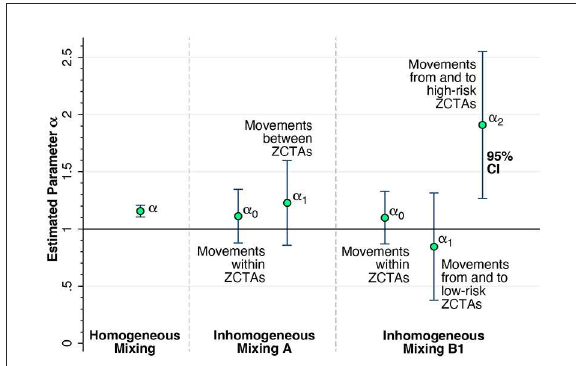
FIGURE9 Estimates of the reproductive number α from a series of geospatial analyses. (Left) Estimate of a uniform parameter α = 1.157 with 95% confidence interval [1.106, 1.208] for the entire regulated region, based upon the assumption of homogeneous mixing. The estimate of α is significantly different from 1.0 (2-sided F-test, p < 0.001). (Middle) Estimates of the parameters α 0 for the effect of movements within ZCTAs and α 1 for between-ZCTA movements, based upon a two-parameter model of inhomogeneous mixing A. (Right) Estimates of the parameters α 0 for the effect of movements within ZCTAs, α 1 for the effect of movements from and to low-risk ZCTAs, and α 2 for the effect of movements from and to high-risk ZCTAs 11223, 11229, 11235, 11224, and 11214, based upon a three-parameter model of inhomogeneous mixing B1. The estimated parameter α 2 = 1.910 with 95% confidence interval [1.268, 2.552] was significantly different from 1.0 (2-sided F-test, p = 0.012). Full details are given in Supplementary Table